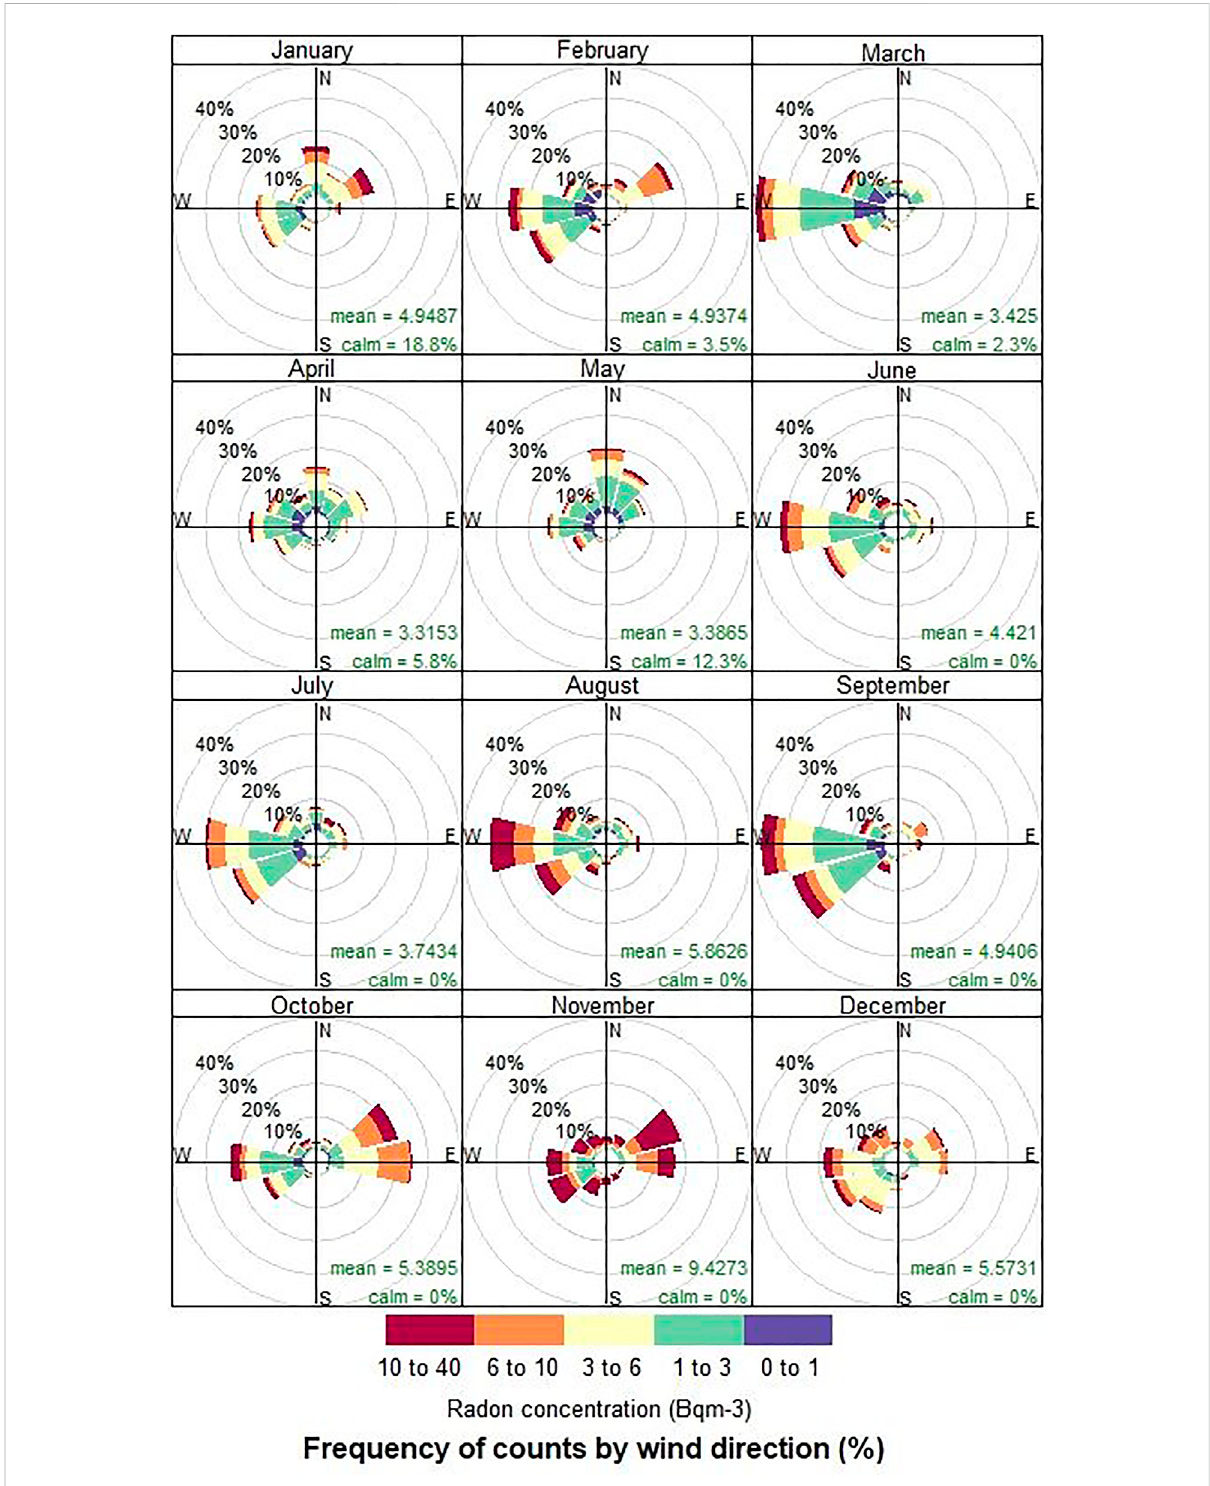
FIGURE 7 Monthly averaged radon roses from the period